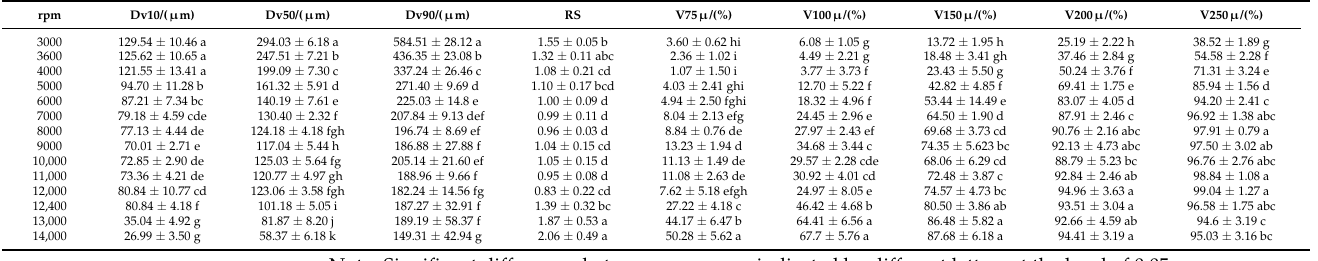
Note: Significant differences between means are indicated by different letters at the level of